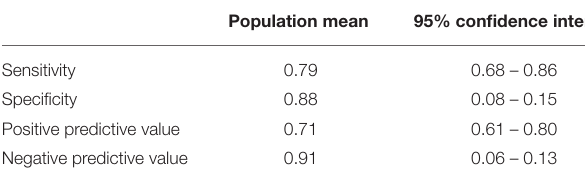
TABLE 2 | Performance of the HeartLogic TM